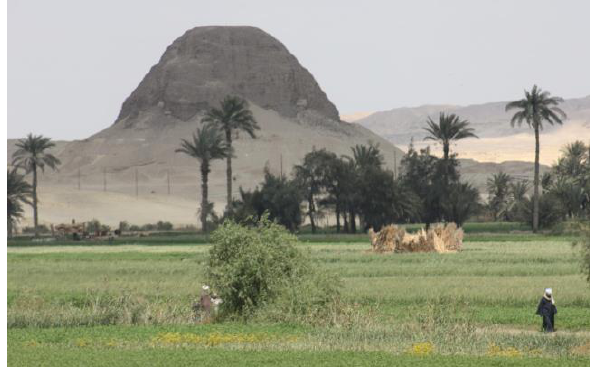
Figure 2. View of the Lahun pyramid from Lahun village, ©